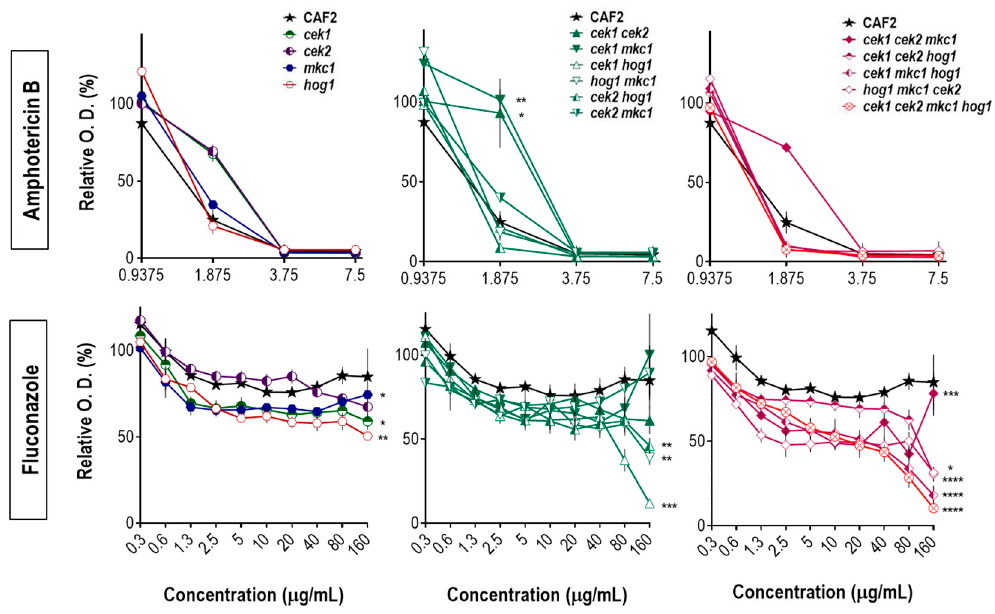
Figure 3. Sensitivity of MAPK mutants to antifungal treatment. Cells from cultures grown overnight at 37 ◦ C were inoculated in a 96-well plate at final O.D. = 0.025 (10 5 cells). Amphotericin B or fluconazole was added to the plates in increasing 2-fold concentrations ranging from 0.030 µ g / mL to 15 µ g / mL (shown only 0.94 µ g / mL to 7.5 µ g / mL-amphotericin B) or 0.32 µ g / mL to 160 µ g / mL (fluconazole). Inoculated plates were incubated at 37 ◦ C for 24 h prior to O.D. assessment. Each strain has been normalized to its positive control (without antifungal) and the growth inhibition curve is shown. Error bars represent the standard error of the mean from two independent experiments. * p < 0.05; ** p < 0.01; *** p < 0.001; **** p < 0.0001 (two-way ANOVA multiple comparison tests related to